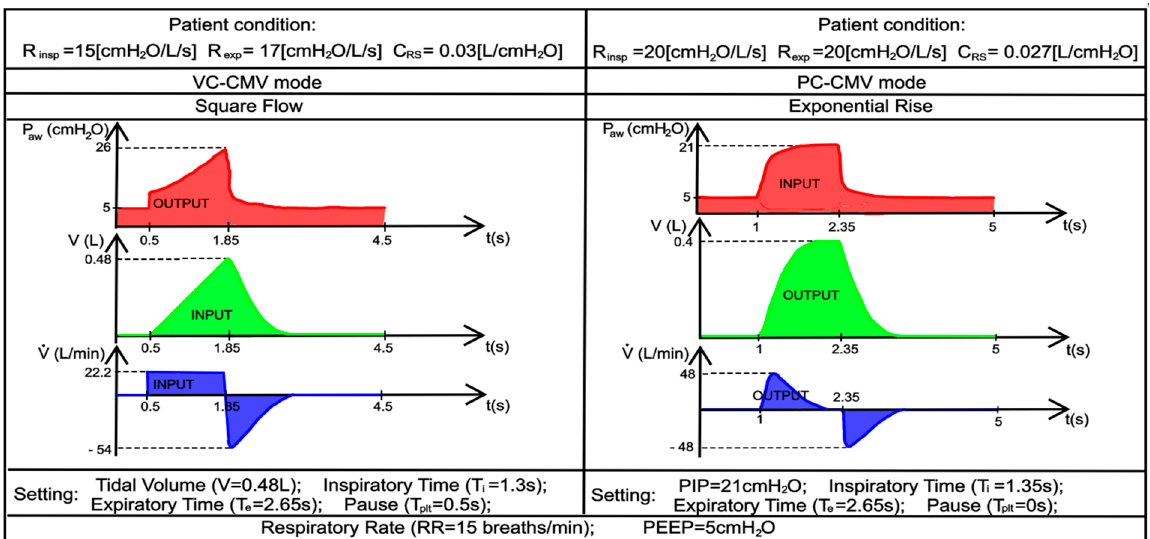
Figure 21. Case 2. Recorded real-life trends of flow, volume, and pressure waveforms in VC-CMV and PC-CMV mode, adapted from [43].